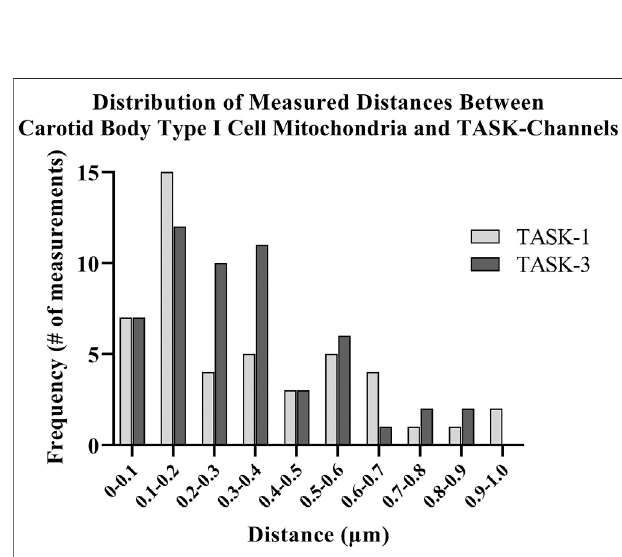
FIGURE 2 | Distances between antibody-labeled (TOMM20) mitochondria and TASK-potassium channels in rat Carotid Body Type I cells were measured using confocal microscopy. Distribution of software- measured distances showed approximately 72% of TASK-1 and approximately 79% of TASK-3 total measurements were ≤ 0.5